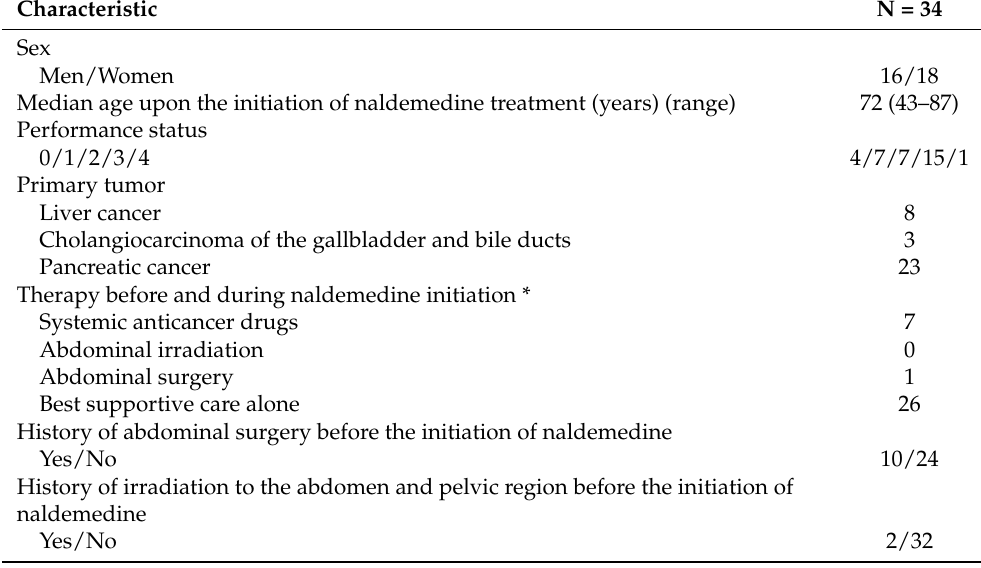
Table 1. Baseline patient